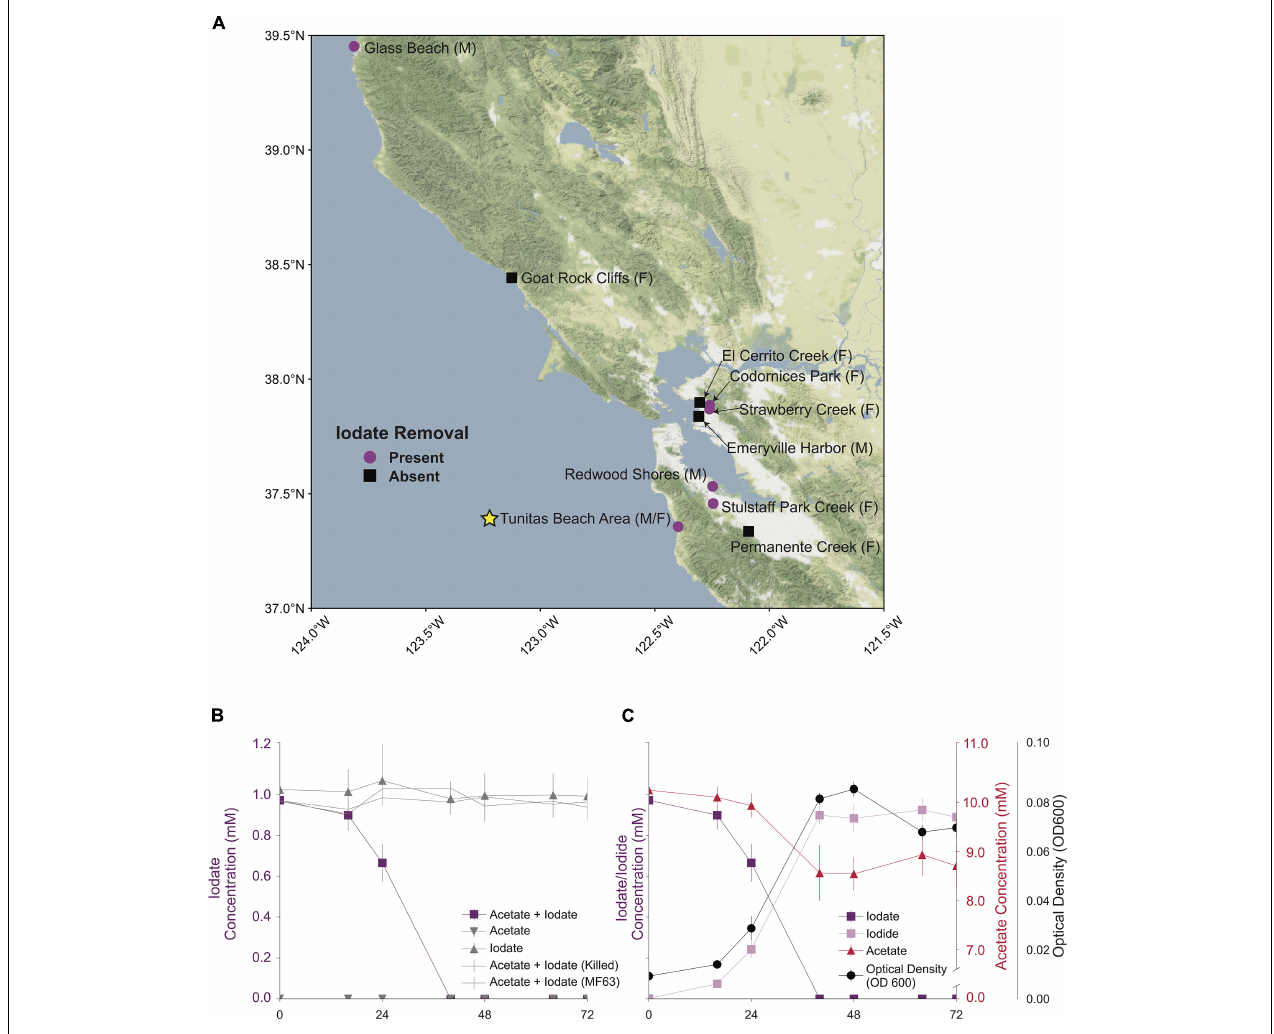
FIGURE 1 | (A) A map of the San Francisco Bay Area showing all sampled locations. Locations sampled for marine enrichments denoted by (M) and locations sampled for freshwater enrichments denoted by (F) Samples from locations showing removal of 2 mM iodate denoted by purple circles ( • ). The location where Aromatoleum toluclasticum sp. TC-10. A yellow star denotes TC-10. Samples from locations without iodate removal are denoted by black boxes ( (cid:4) ). (B) A time course showing removal of iodate in the acetate + iodate condition and no removal of iodate in alternative conditions. (C) A time course showing the removal